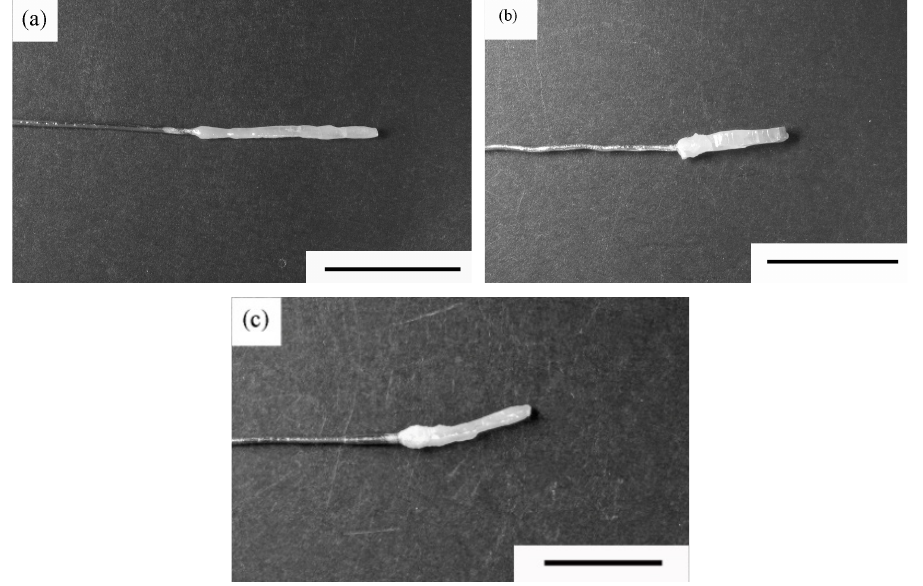
Figure 8. Typical as-grown single crystals of ( a ) KNN: (K,Na)NbO ; ( b ) KNRN: 3 (K,Na,Rb)NbO ; and ( c ) KNCN: (K,Na,Cs)NbO , reprinted with permission from [10,41,43]. 3 3 Copyright 2009 World Scientiflc Publishing Company; 2010 Elsevier; 2011 WILEY-VCH Verlag GmbH & Co. KGaA. Scale bar: 10